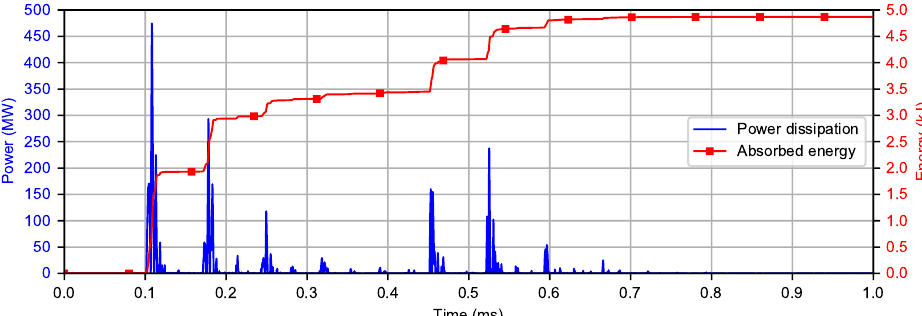
Figure 5. Absorbed energy of the SPD inside a nacelle with 60 kA and 4/75 µ s (first stroke), and 20 kA and 1/75 µ s (subsequent